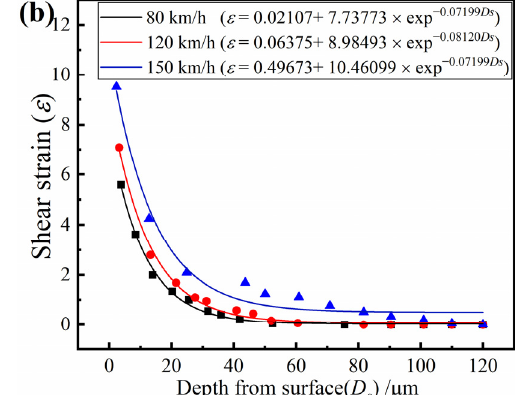
Figure 9. Curves of the distribution of hardness.